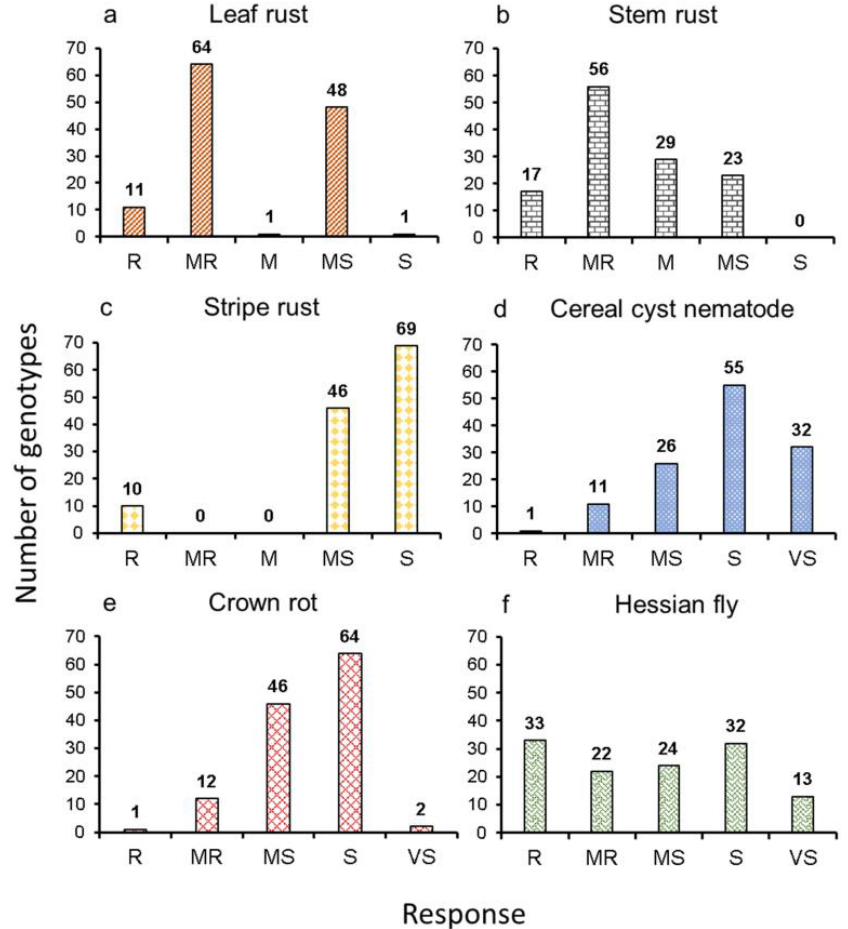
Figure 1. Frequency distribution of response to ( a ) leaf rust, ( b ) stem rust, and ( c ) stripe rust at the adult plant stage, ( d ) cereal cyst nematode, ( e ) crown rot, and ( f ) Hessian fly in 125 synthetic hexaploid wheat. R, Resistant; MR, Moderately resistant; M, Intermediate; MS, Moderately susceptible; S, Susceptible; and VS, Very